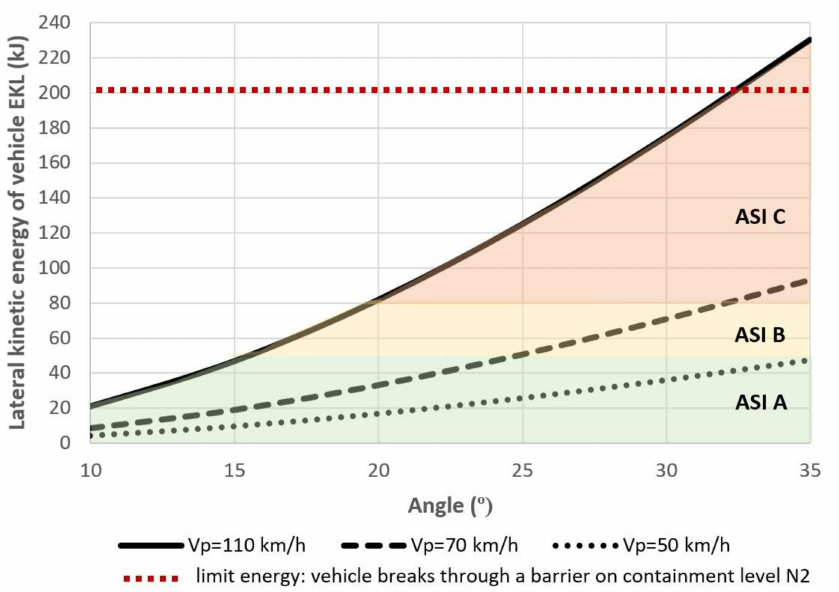
Figure 17. Relations between lateral kinetic energy EKL of a vehicle impacting a barrier placed after a SafeEnd device and vehicle velocity Vp (and related to ramp radius R) and impact angle KAT based on the simulation